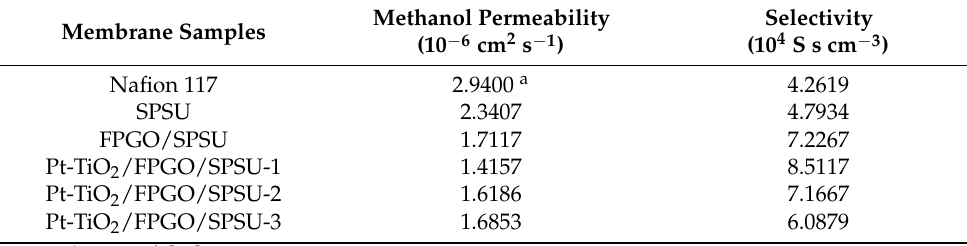
Table 4. Methanol permeability and selectivity of Nafion 117 and all the